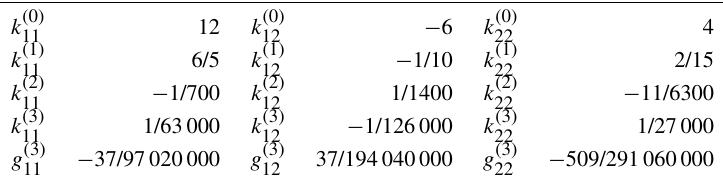
Table 1. Beam characteristic coefficients of the BCM matrices (Awtar et al.,